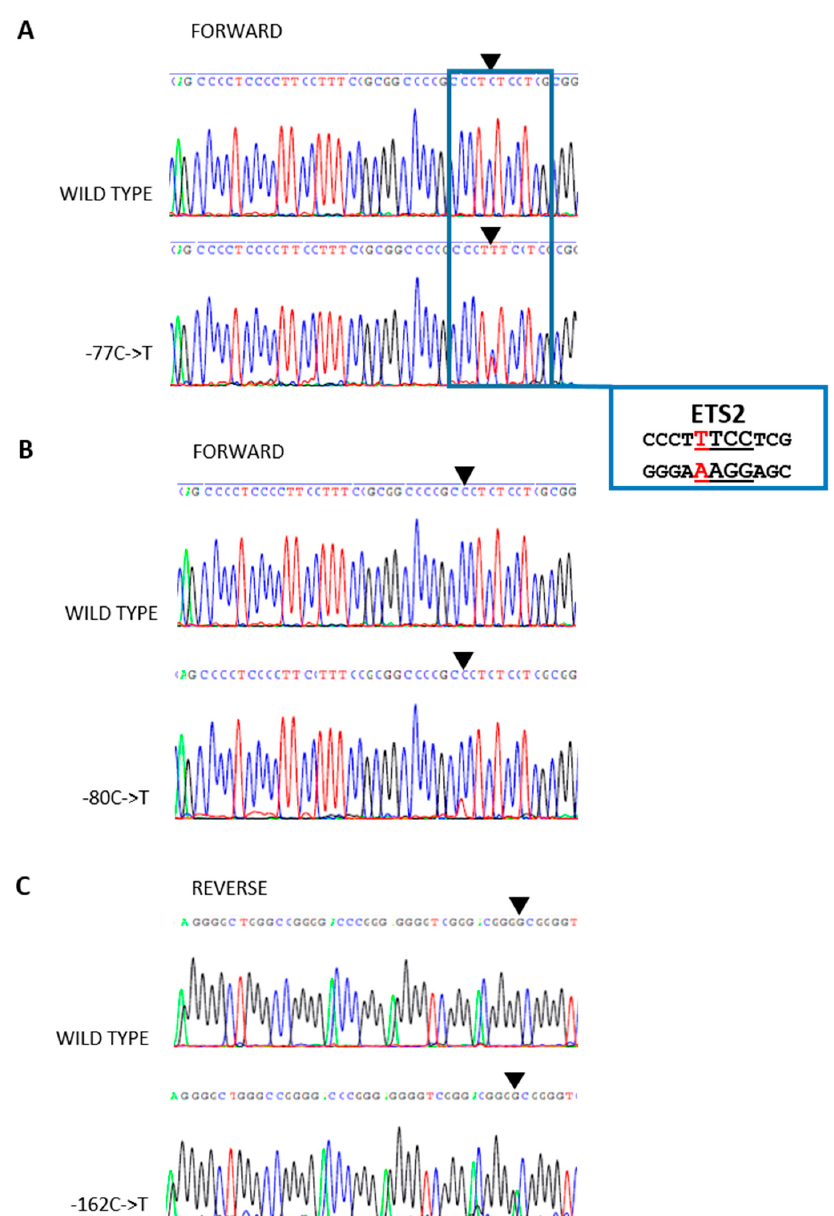
Figure 2. New TERT promoter ( TERT p) alterations detected in the analyzed papillary thyroid carcinoma (PTC) cohort. ( A ) Alteration − 77 C->T, which created a putative consensus binding site (GGAA) for transcription factor ETS2; ( B ) alteration − 80 C->T; ( C ) alteration − 162 C->T. The black triangles point to the nucleotide positions of the nucleotide substitutions.